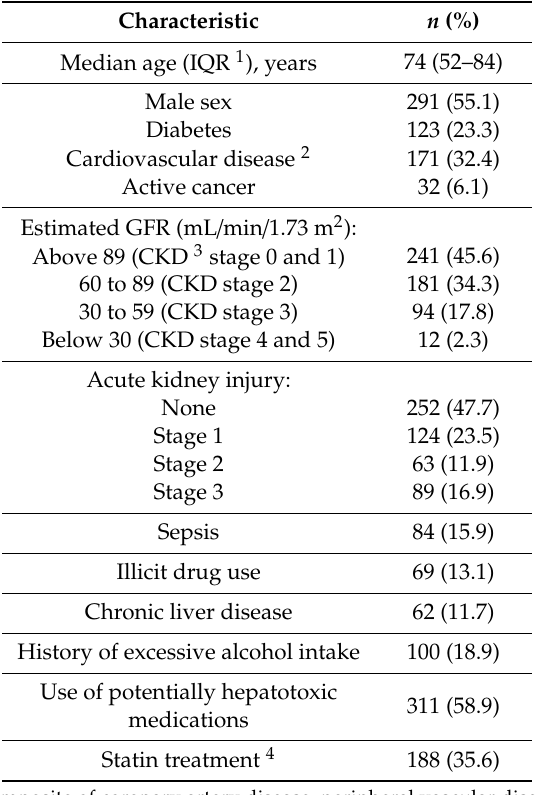
Table 1. Characteristics of included patients ( n = 528).